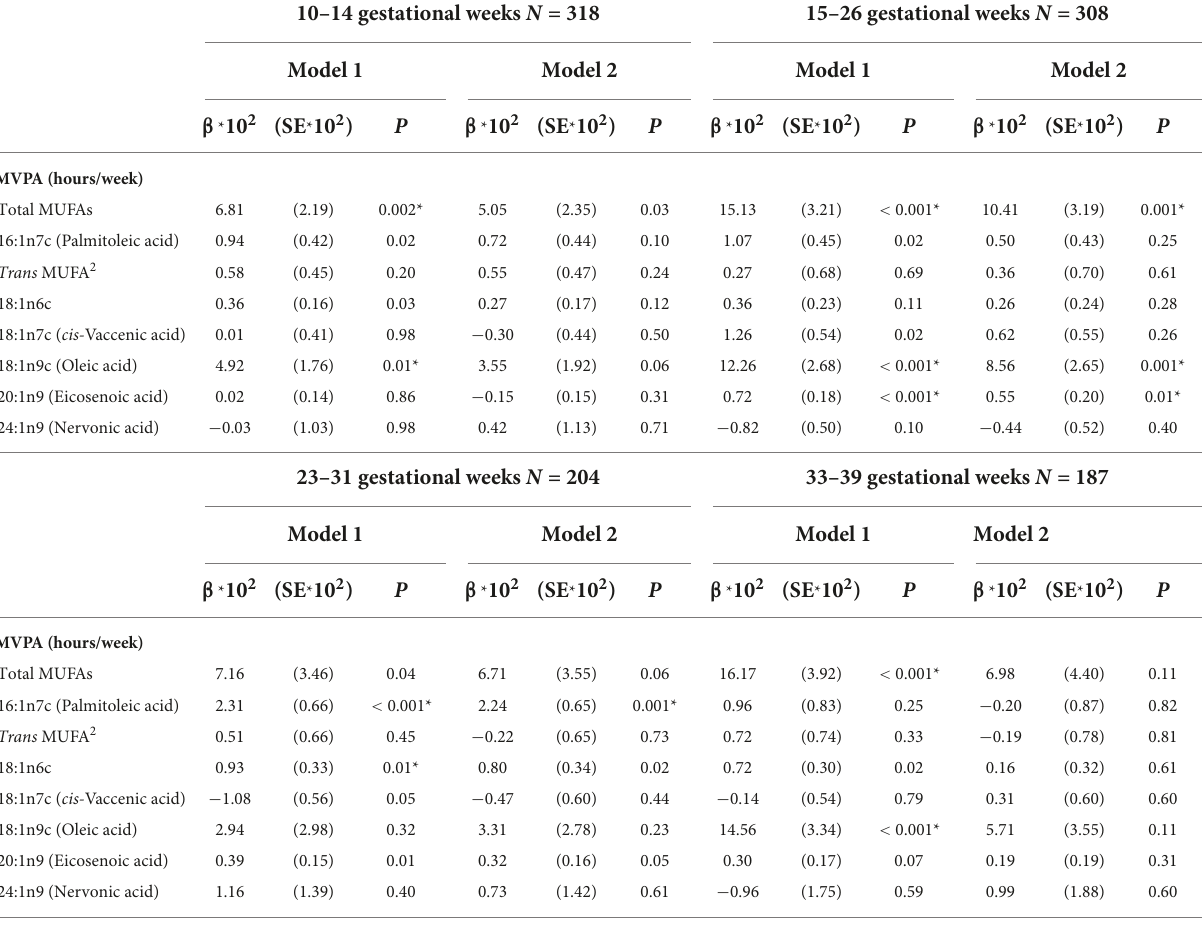
TABLE 2 Associations of moderate-to-vigorous physical activity (MVPA) with plasma monounsaturated fatty acids (MUFAs). 1